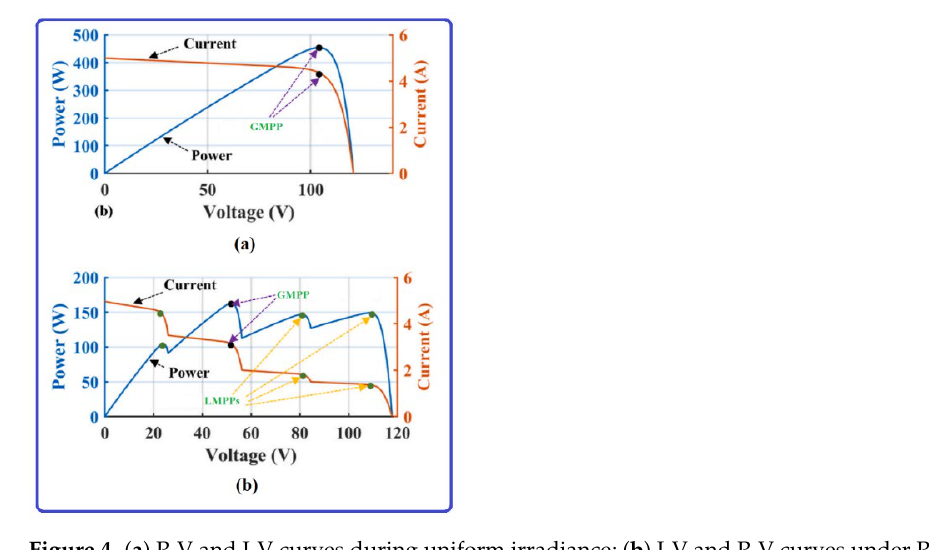
Figure 4. ( a ) P-V and I-V curves during uniform irradiance; ( b ) I-V and P-V curves under PSCs.